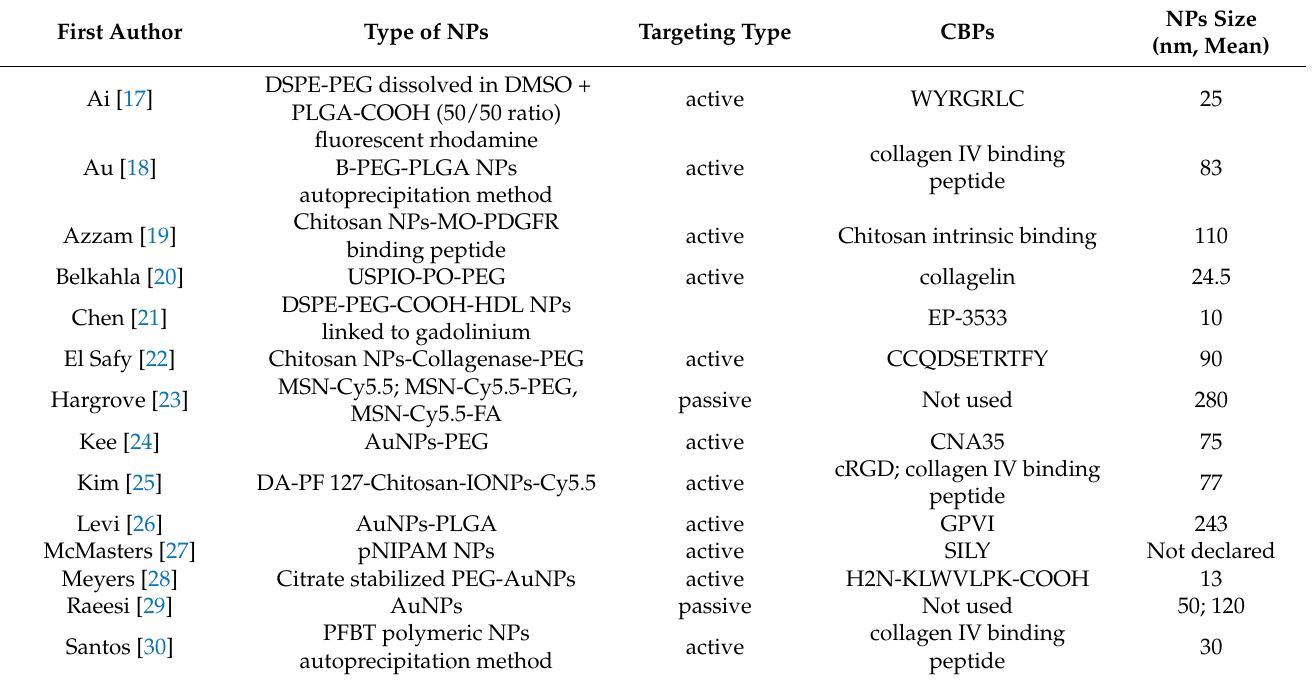
Table 2. Nanoparticle